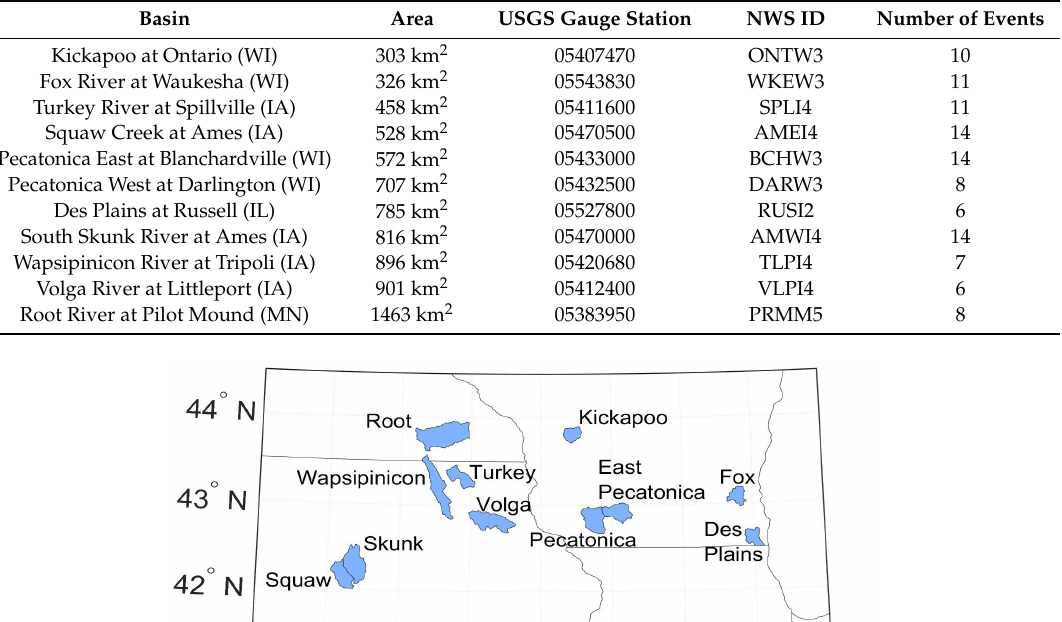
Table 1. Study basins, basin area, United States Geological Survey (USGS) gauge number, National Weather Service (NWS) forecast point identification, and the number of events analyzed for each basin. Bold signifies the gauges for which the North Central River Forecasts Center (NCRFC) issues probabilistic streamflow forecasts.